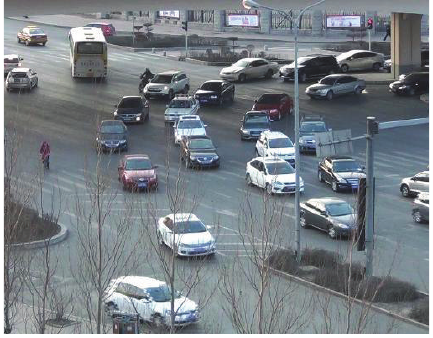
Figure 7: The quadruple left-turning lanes intersection.